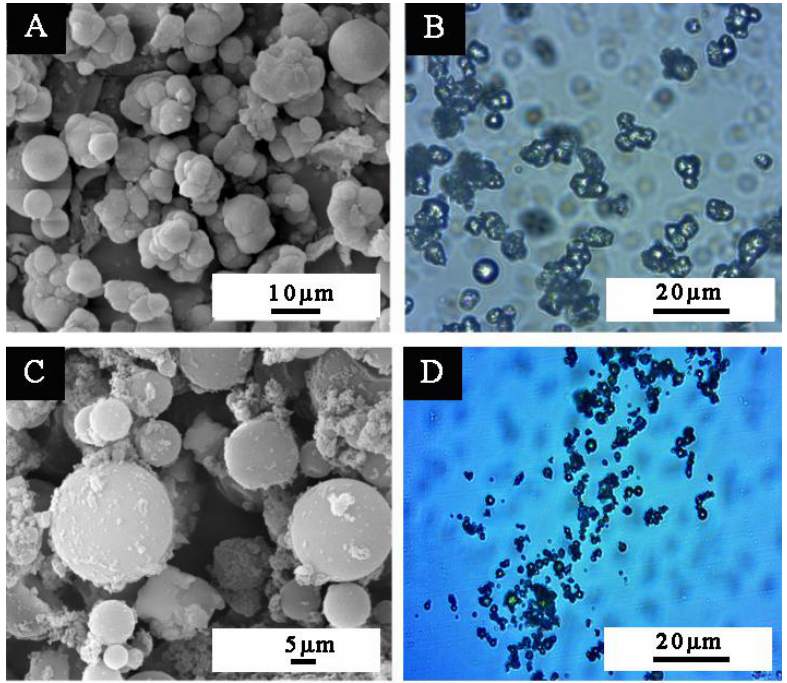
Figure 1. Morphology of waterborne acrylic resin microcapsules: SEM ( A ), OM ( B ) light diffraction ring phenomenon of waterborne acrylic resin microcapsules. Morphology of fluorane microcapsules: SEM ( C ), OM ( D ) light diffraction ring phenomenon of fluorane microcapsules.